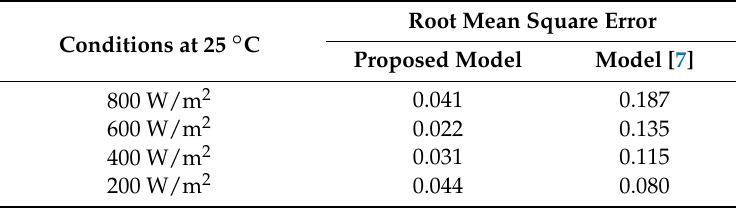
Figure 10. RMSE values of proposed model against I-V curve of different conditions of mono-crystalline module [25]. Table 2. RMSE of two models against distinct